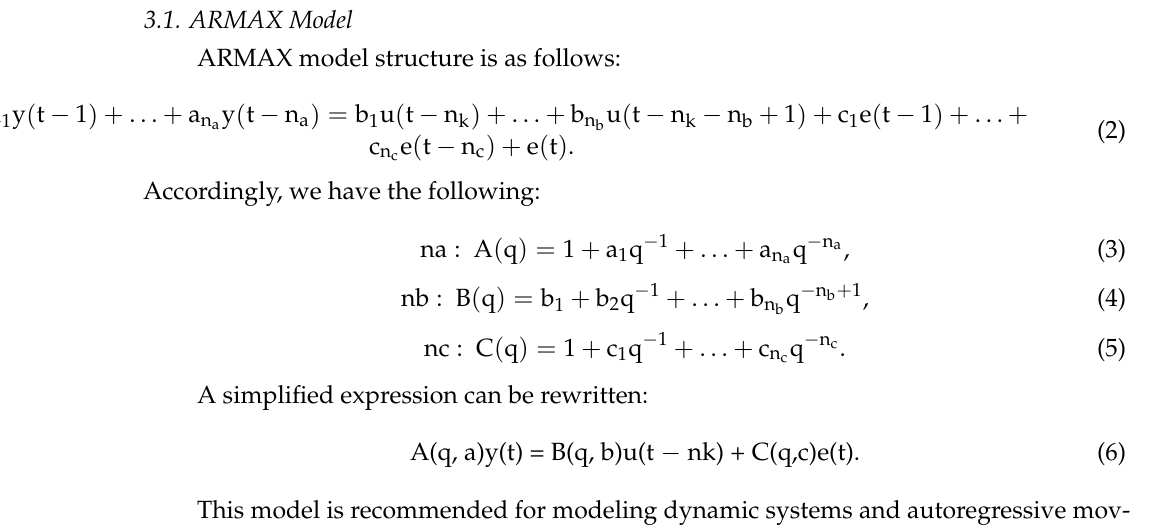
Figure 3. The schematic diagram of a generalized typical discrete-time linear mathematical model. Depending on the polynomial combinations of A, B, C, D, and F, there can be thirty- two structures of the mathematical models. In the study, three models were used in parametric identification (autoregressive moving average model with exogenous inputs model (ARMAX), Output Error Model (OE), Box–Jenkins (BJ)). These models were selected to determine the parameters of the mathematical model of the hydro unit (to obtain the best